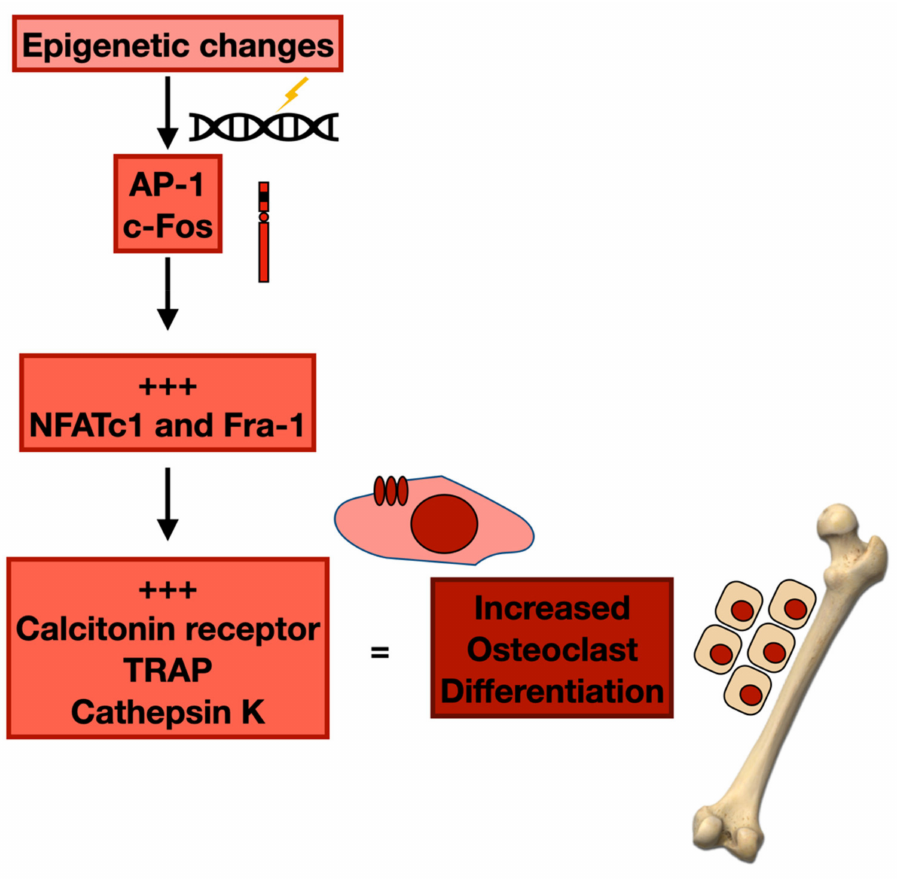
Figure 2. Epigenetic changes and osteoclast